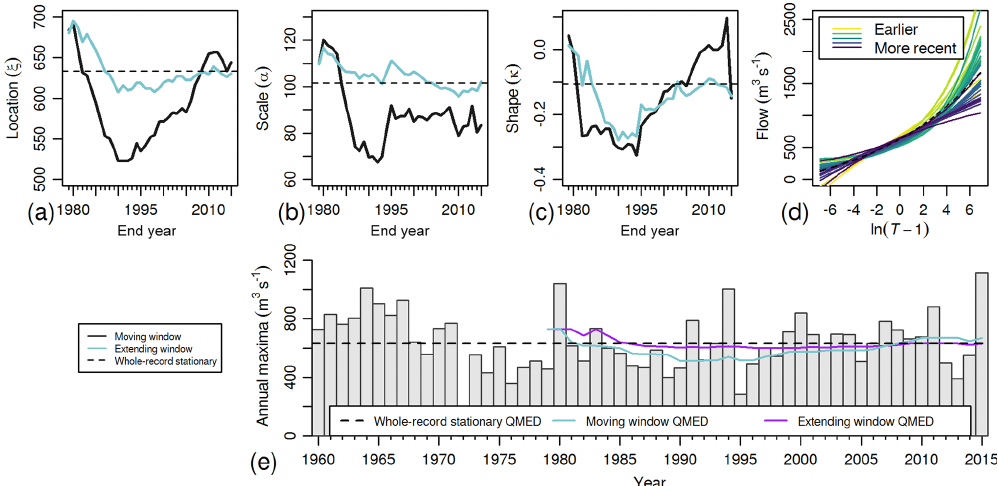
Figure 3. Example of results from fitting stationary parameters on the Ribble at Samlesbury in different time windows. Parameters (a– c) computed under moving windows, extending windows and on the whole record. AMAX series with QMED moving estimate (e) , and flood frequency curves generated from the moving window analysis and from the whole record (d) . Note that the value from 1972 to 1973 is missing, but this does not affect the analysis. Lines on figures (a) , (b) , (c) and (e) are plotted corresponding to the end of the moving or extending windows.